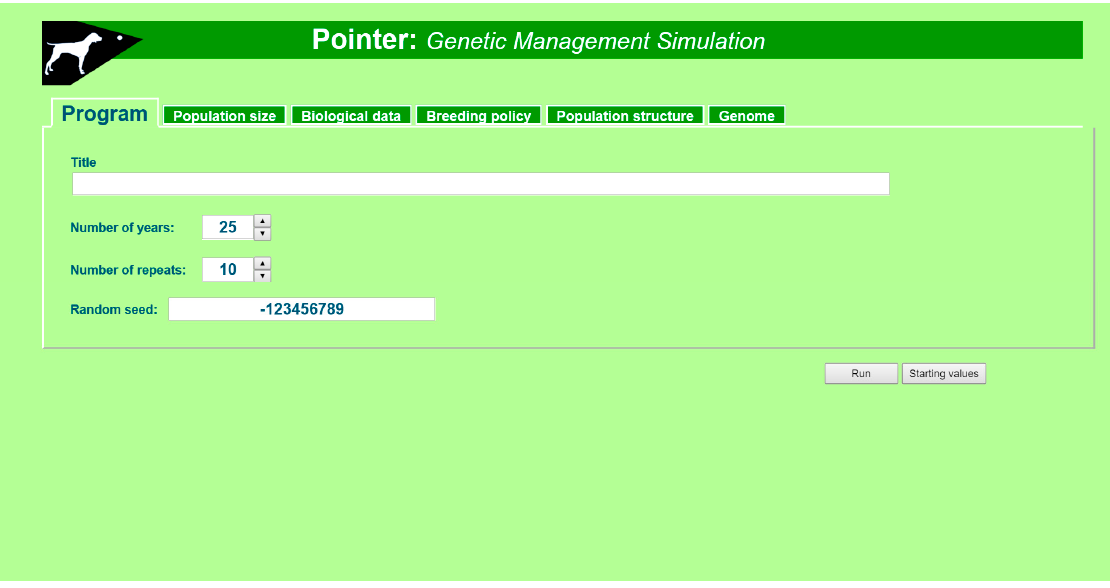
Figure 2. Opening screen of Pointer. Pointer simulates populations with different genetic management to determine inbreeding and kinship rates. Table 2. Overview of input for the Pointer